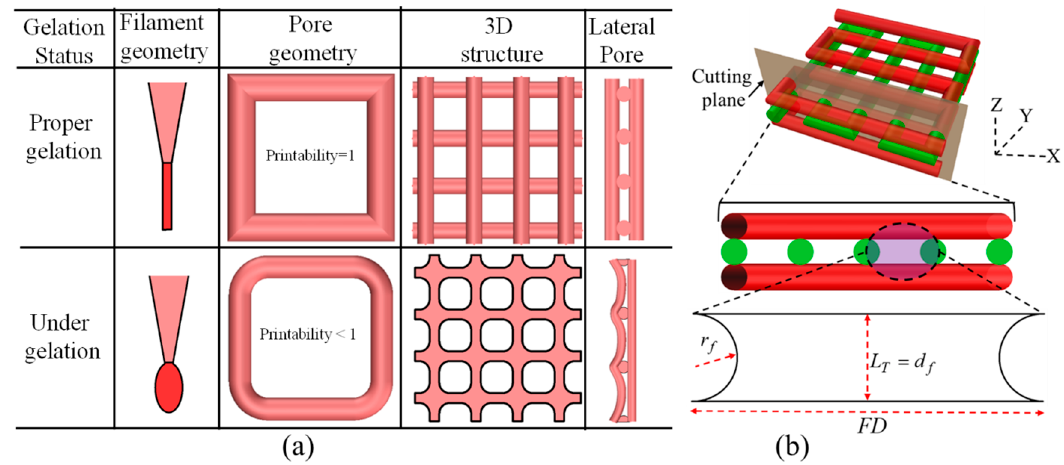
Figure 6. ( a ) Qualitative; and ( b ) Quantitative test of lateral pore.